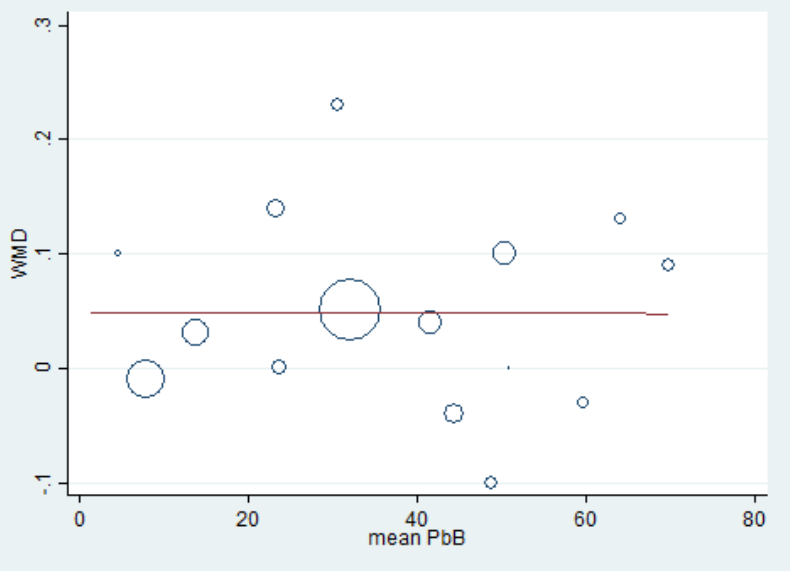
Figure 8. Meta-regression analysis of WMD (creatinine) and mean BLL (µg/dL). WMD: Weighted Mean Difference, PbB: Blood Lead (µg/dL).